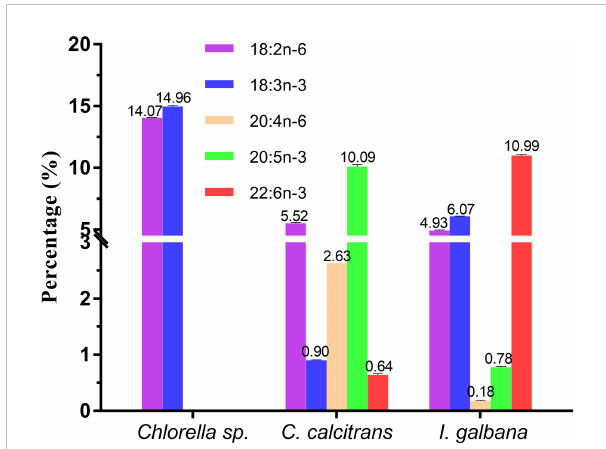
FIGURE 6 Representative fatty acids composition (%) of Chlorella sp., Chaetoceros calcitrans and Isochrysis galbana .